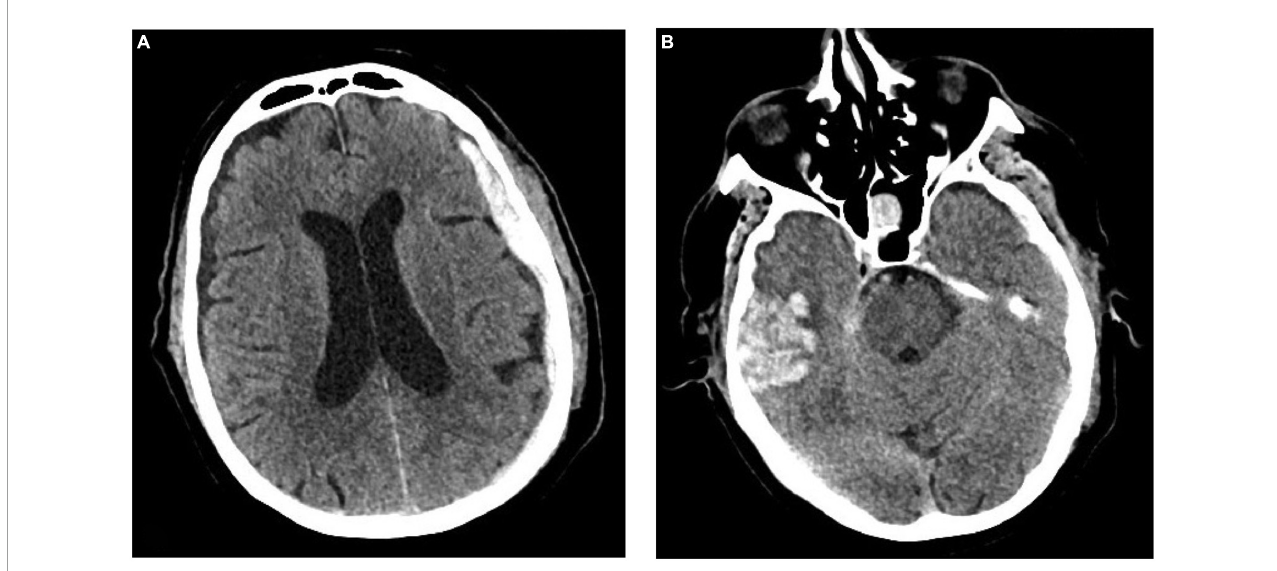
FIGURE3 Exemplary cranial CT images of a 73-year-old male patient admitted to the emergency department of the University Hospital Frankfurt after a ground-level fall under ASA premedication. The CT scan shows the simultaneous presence of a subdural hematoma (A) and an intracerebral hemorrhage (B) . ©Department of Diagnostic and Interventional Radiology, University Hospital Frankfurt, Frankfurt am Main,